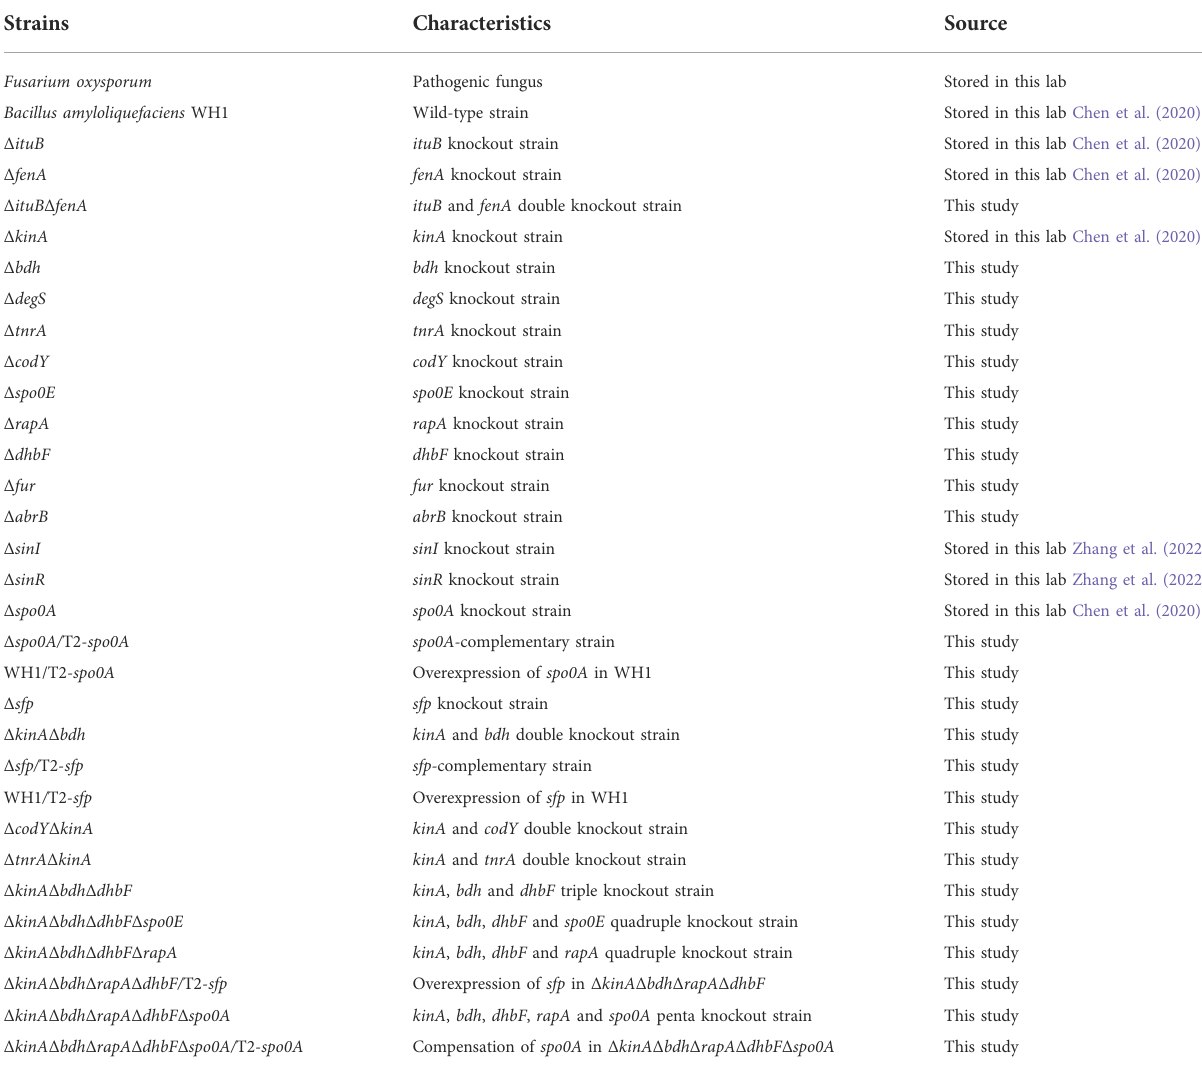
TABLE 1 Bacterial strains used in this study. Strains